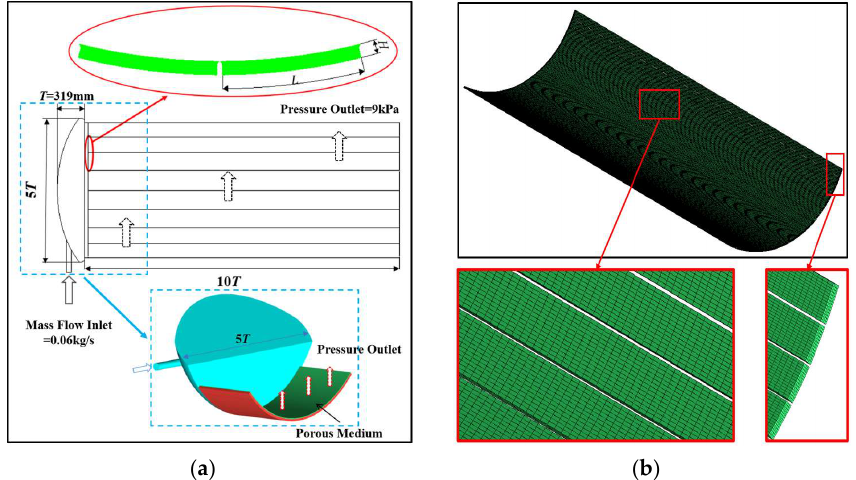
Figure 2. CFD computational domain and grid diagram. ( a ) CFD computational domain; ( b ) Airway grid. Table 1. Selection factors and levels.